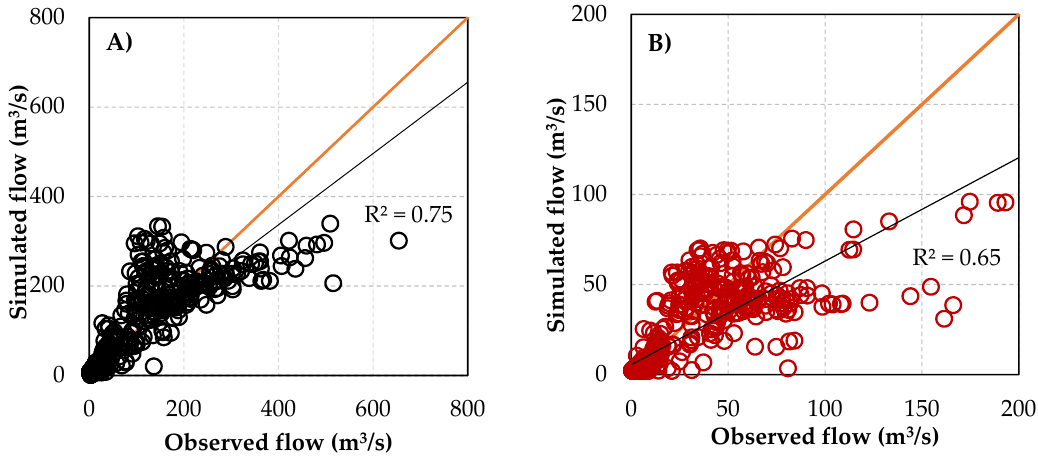
Figure 4. Scatter plot of observed and simulated flow for the validation period: ( A ) Main Beles simulated flow performance for the validation period; and ( B ) Gilgel Beles simulated flow performance for the validation period.